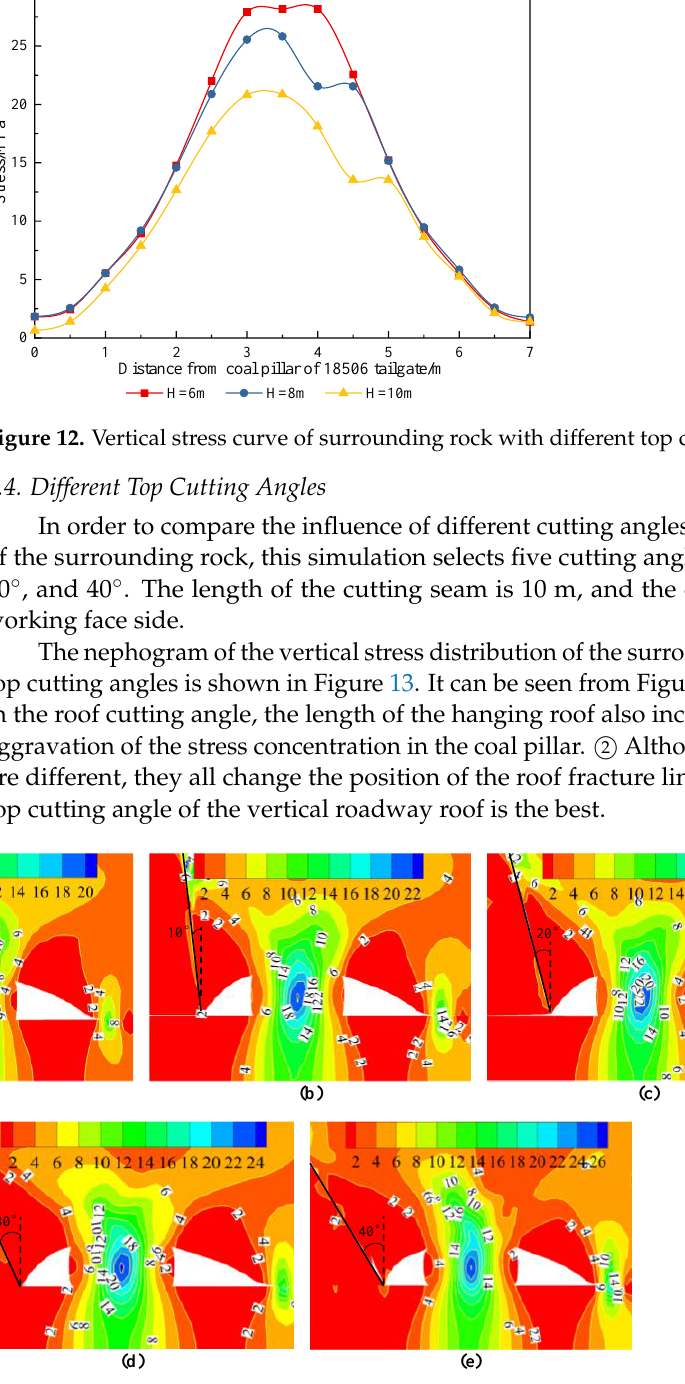
Figure 11. Nephogram of vertical stress distribution of surrounding rock with different top cutting heights: ( a ) H = 6 m; ( b ) H = 8 m; ( c ) H = 10 m.